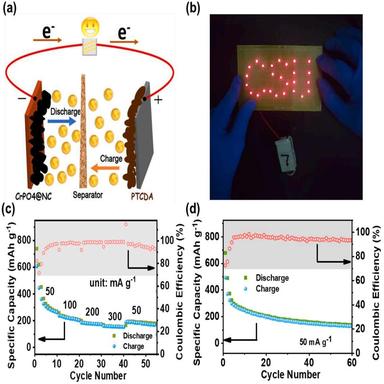
(a) Schematic illustration of CrPO4@NC//PTCDA full cell, (b) digital pictures of a LED logo lighted by the CrPO4@NC//PTCDA, (c) rate capability and (d) cyclic performance of the full cell.